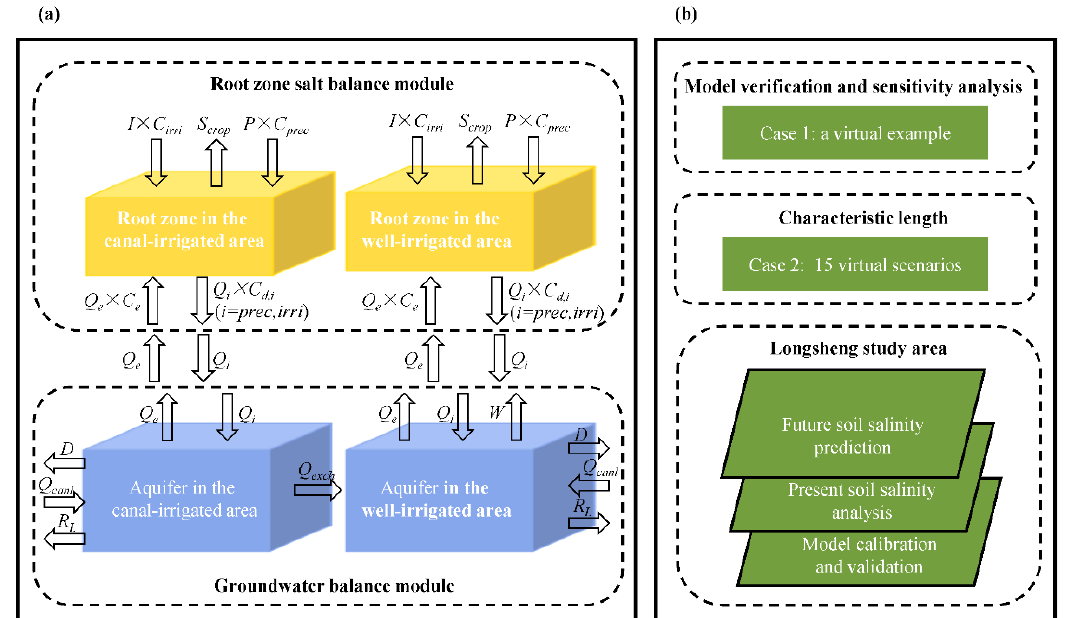
Figure 1. Sketch of the model development and application, ( a ) model development, and ( b ) model application. I , P and Q e are the irrigation, precipitation and capillary rise water; Q irri and Q prec are downward percolation from irrigation or precipitation at the bottom of root zone; Q exch is the groundwater exchange from the canal-irrigated area to the well-irrigated area; R L , D , W , Q canl are the lateral flux from external regions, drainage, pumping water, and seepage losses from canal system; C irri and C prec are the concentration of irrigation and precipitation water; C d , irri and C d , prec are the concentration of percolated irrigation and precipitation; C e is the concentration of capillary rise; S crop is salt uptake by crops.